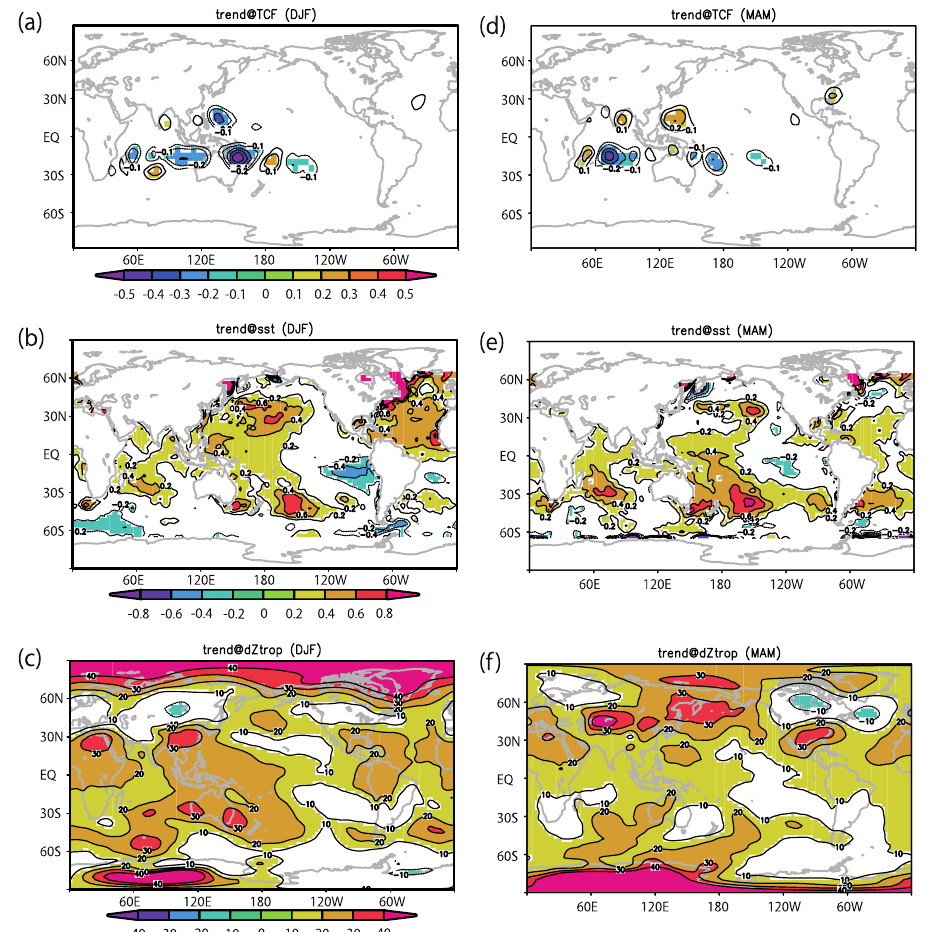
Figure 12. Difference in seasonal means between 1983 – 2001 and 2002 – 2020. ( a ) TCF, ( b ) SST, and ( c ) z200-z850 in DJF. ( d – f ) are same as ( a – c ) but during MAM.